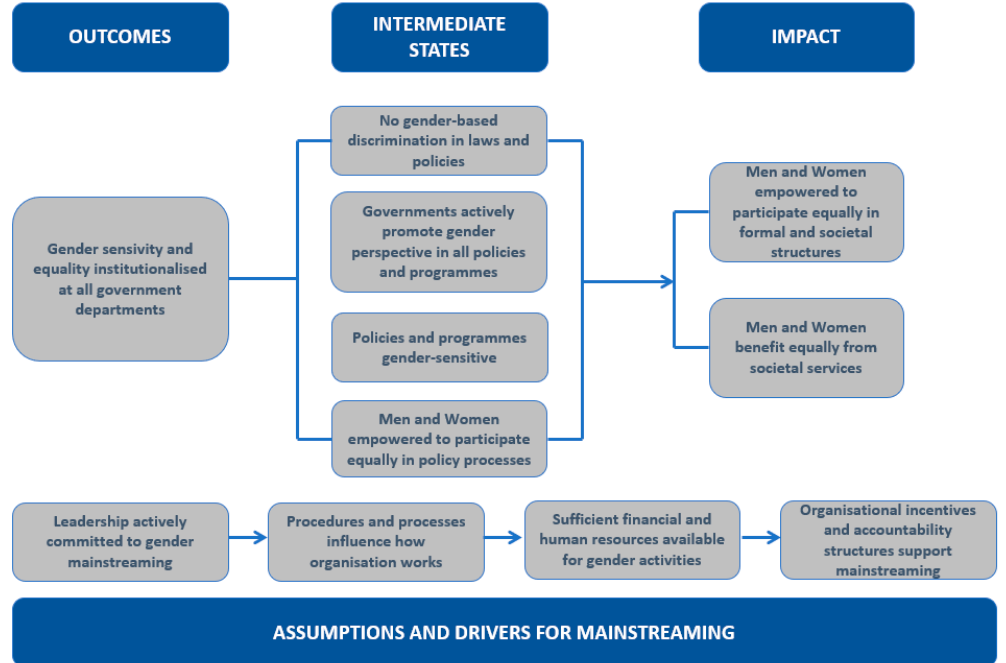
Figure 1. Theory of change model (based on the African Development Bank Group 2011).